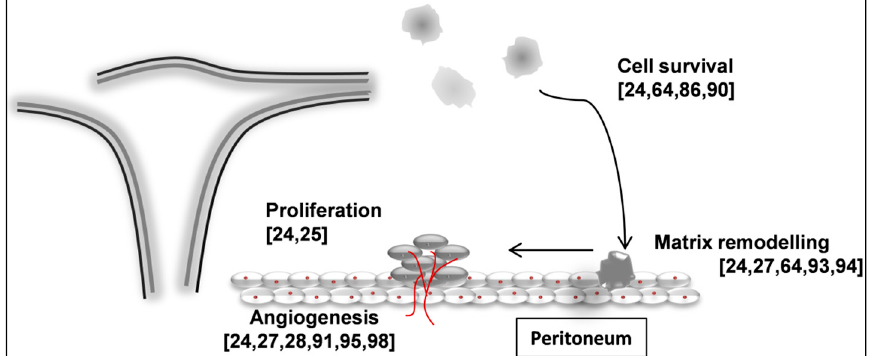
Figure 3. Main systems affected in endometriosis and the references for the most relevant studies about the role of miRNAs regulating them in this disease in square brackets. Red lines represent new blood vessels in formation and red dots cells nuclei.